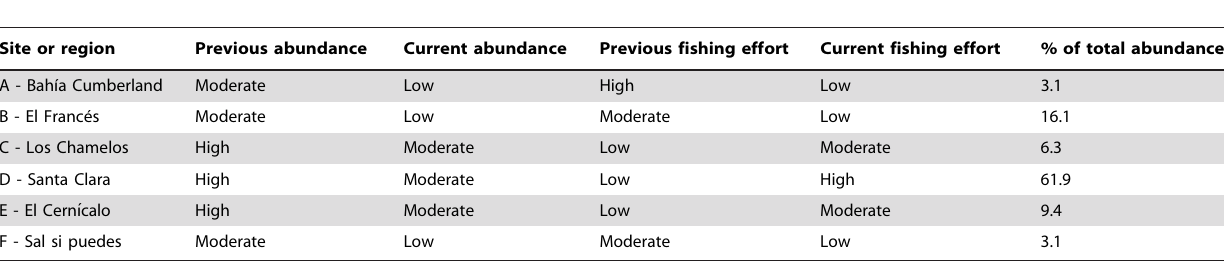
Refer to Figure 3 (panels A & B) for location of sites and regions. doi:10.1371/journal.pone.0013670.t002 PLoS ONE |